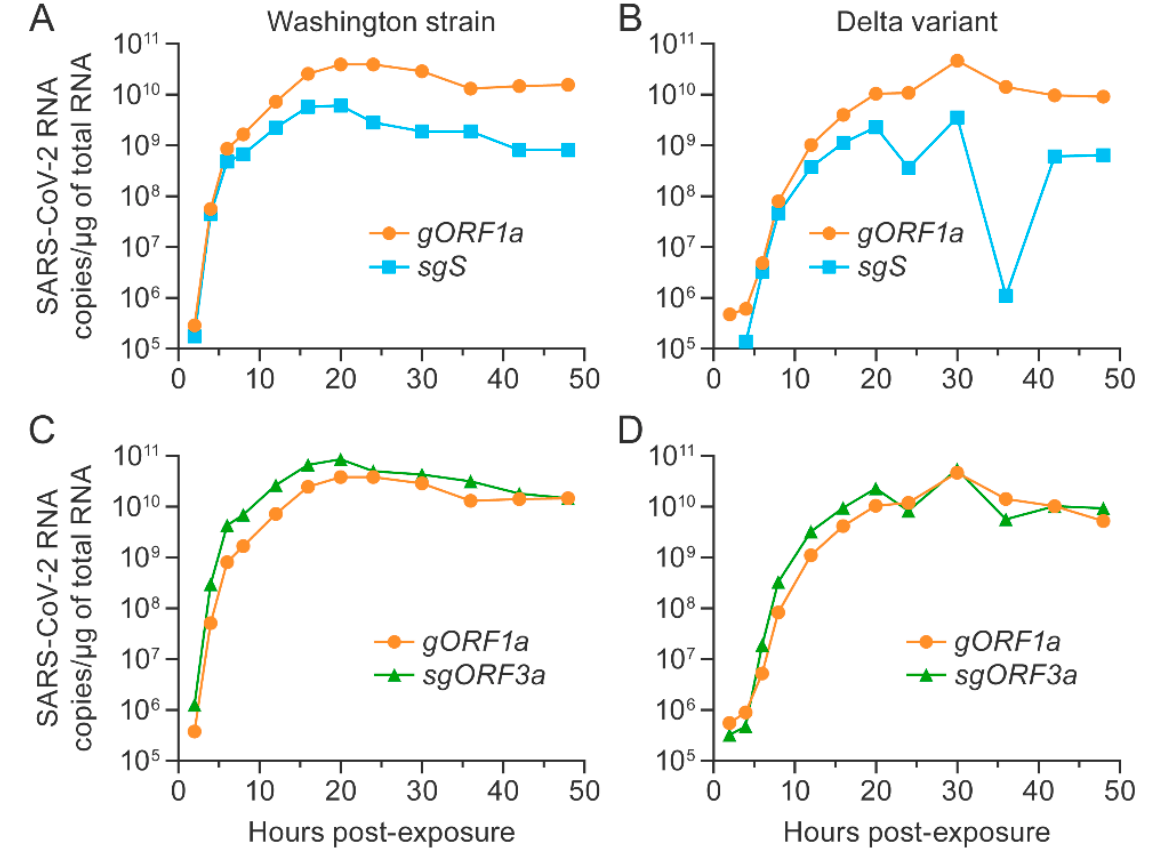
Figure 5. Longitudinal detection of SARS-CoV-2 genomic and subgenomic RNAs in Vero E6 cells expressing TMPRSS2. SARS-CoV-2 genomic and subgenomic RNAs were detected longitudinally using the gORF1a + sgS duplex RT-qPCR assay ( A , B ) and the gORF1a + sgORF3a duplex RT-qPCR assay ( C , D ) in TMPRSS2 Vero E6 cells that had been exposed to SARS-CoV-2. Experiments were performed thrice in 6-well plates, and duplex assays were performed in triplicates for each well. SARS-CoV-2 = severe acute respiratory syndrome coronavirus 2; RT-qPCR = real-time reverse tran- scription PCR; TMPRSS2 = human transmembrane serine protease 2.